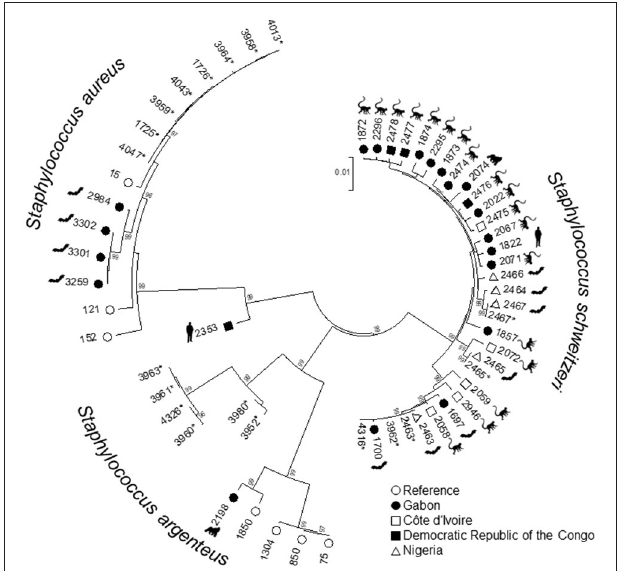
FIGURE 2 | Genetic relatedness of Staphylococcus aureus complex from bats in Nigeria. A Neighbor-Joining-Tree was constructed using the concatenated sequences of the multilocus sequence typing (MLST) scheme. Isolates from this study (*) were combined with sequence types (ST) associated with S. aureus , Staphylococcus schweitzeri, and Staphylococcus argenteus . Labels show the respective STs. The hosts of the reference isolates (e.g., bats, monkeys, gorillas, humans) are indicated. Only bootstrap values of ≥ 95 (inferred from 500 replicates) are shown next to the